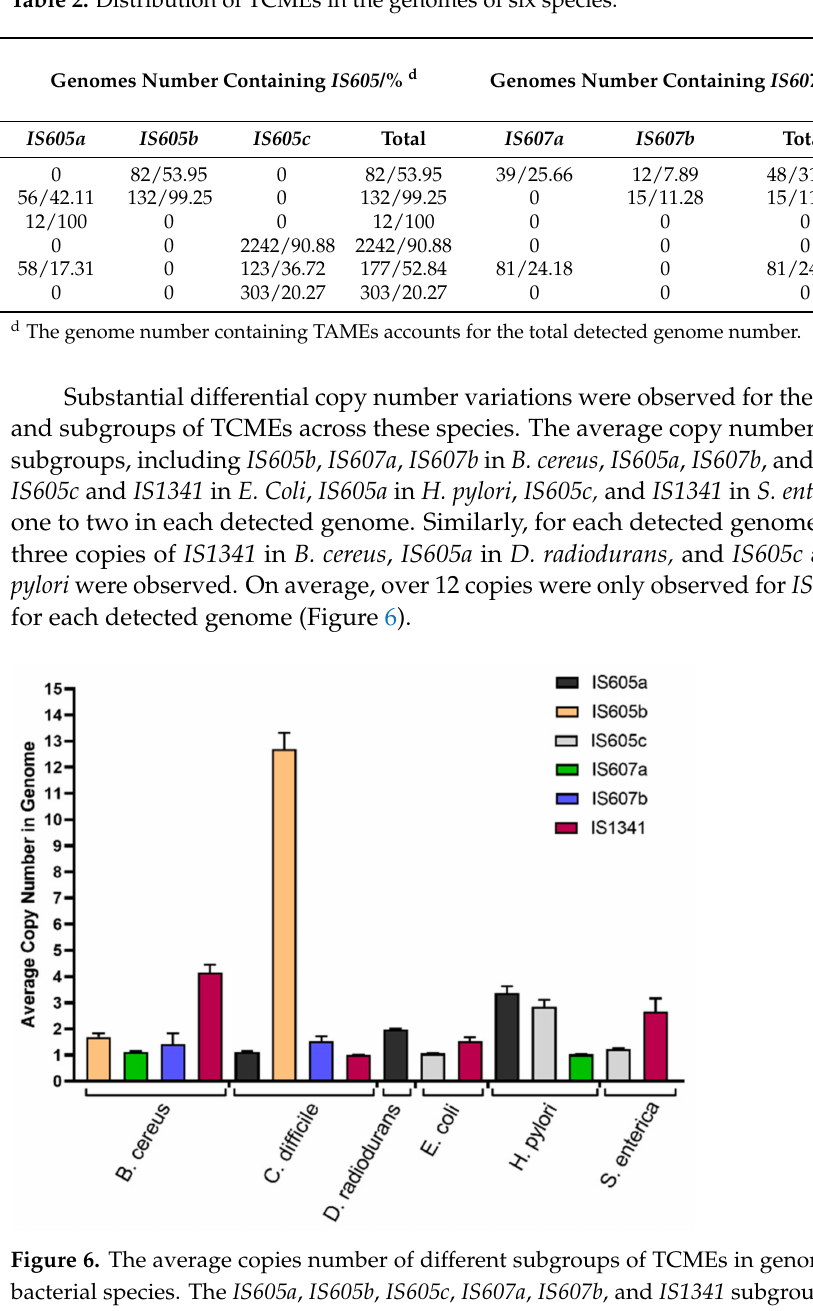
Table 2. Distribution of TCMEs in the genomes of six species.